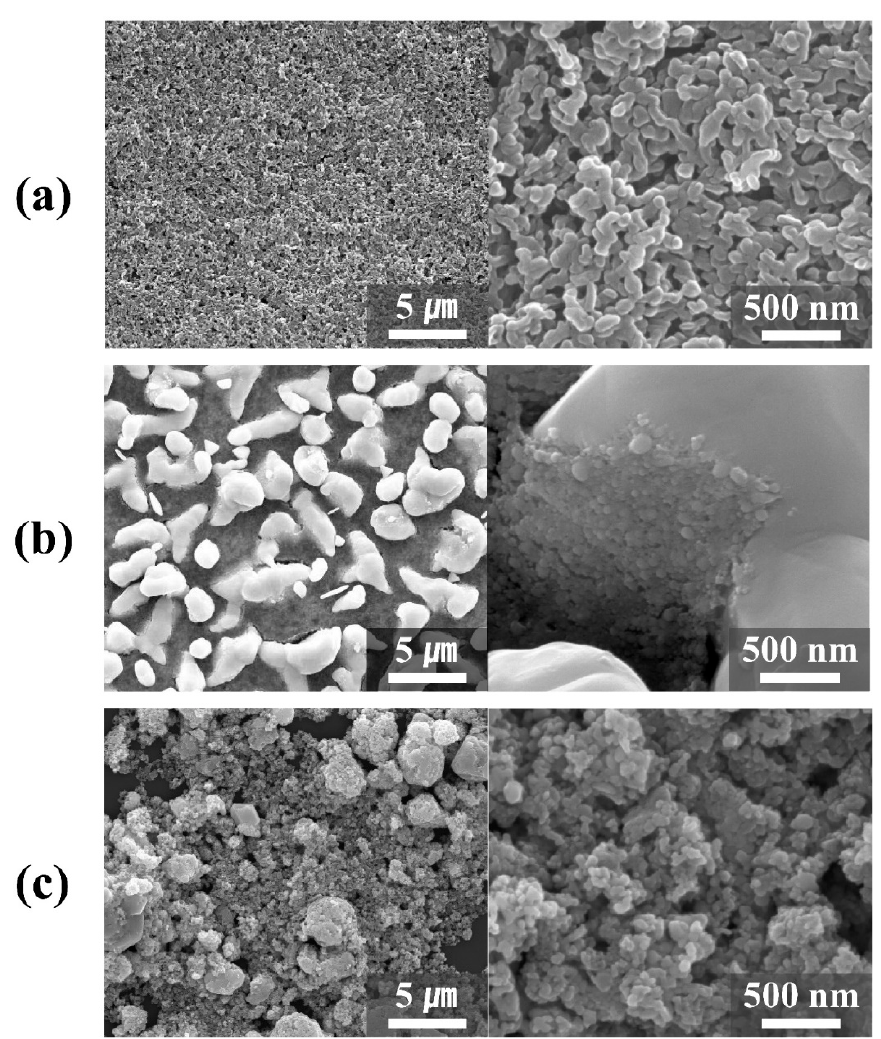
Figure 3. Scanning electron microscope images for surface of ( a ) AgSC18@Si, ( b ) Ag-hc@Si, and ( c ) AgNP@Si.